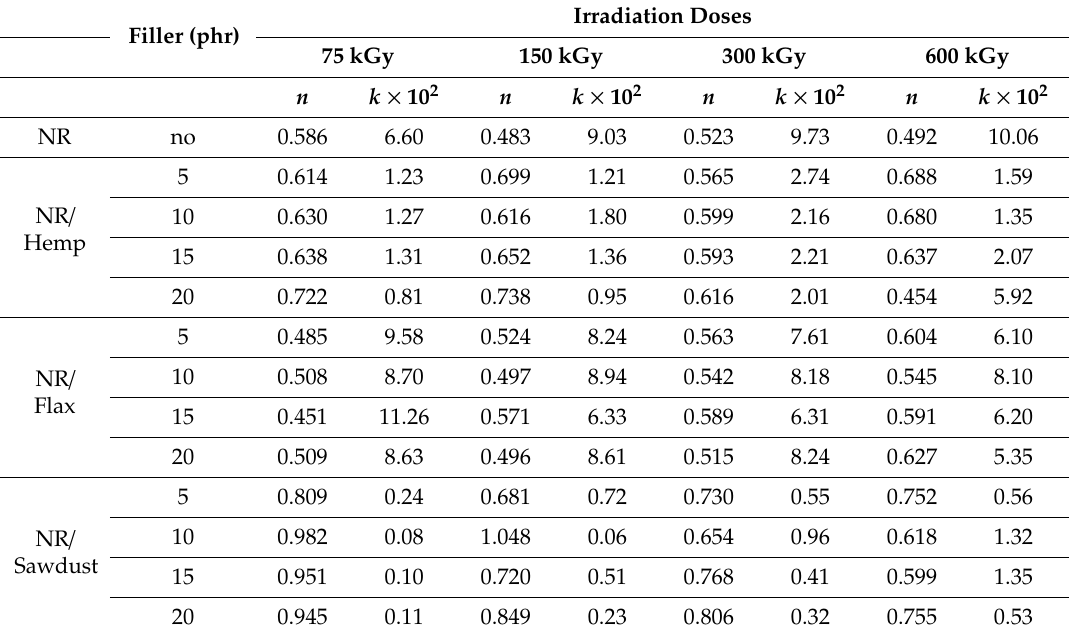
Table 5. Values of n and k × 10 2 parameters as a function of irradiation